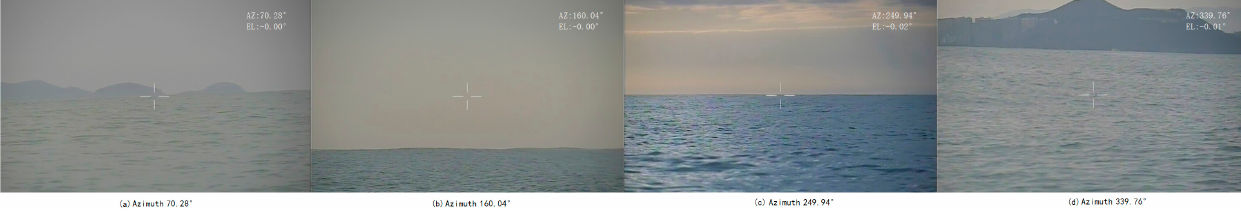
Figure 8. The LOS deviates up and down around the sea–sky line when the electro-optical device moves during circumferential scanning.